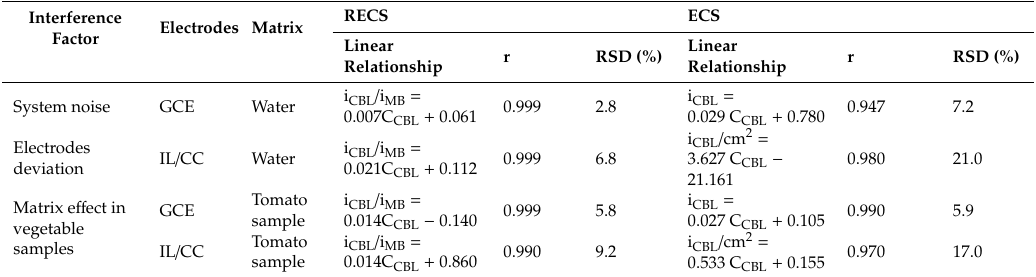
Table 3. Comparison between ratiometric electrochemical sensor (RECS) and electrochemical sensor